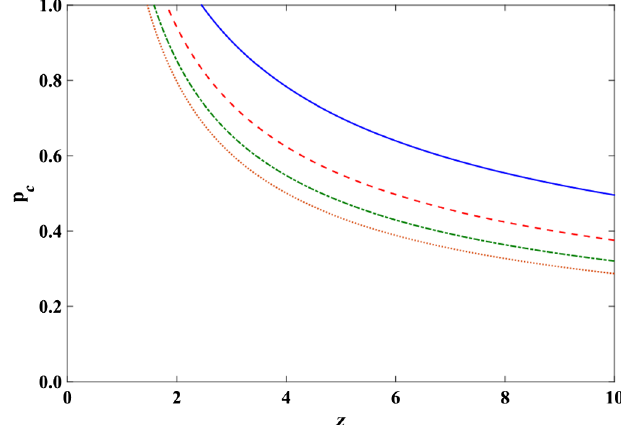
FIG. 3. The percolation threshold p c is plotted versus the average degree z of each layer for Poisson multiplex networks with M ¼ 2 , 3, 4, 5 layers indicated, respectively, with blue solid, red dashed, green dot-dashed, and orange dotted lines.